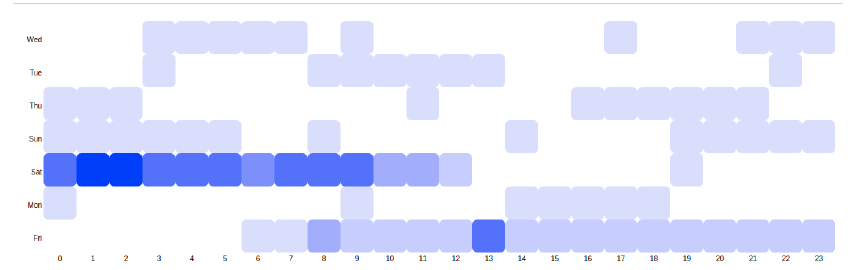
Figure 17. Alarm system